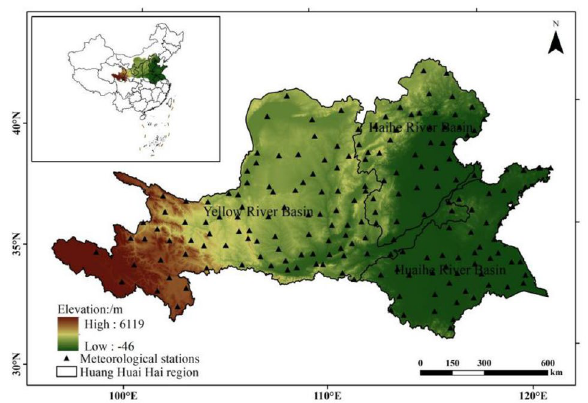
Figure 1. Location of the study areas. The figure was made in the ArcGIS 10.2 platform (https:// www. esri. com/ en- us/